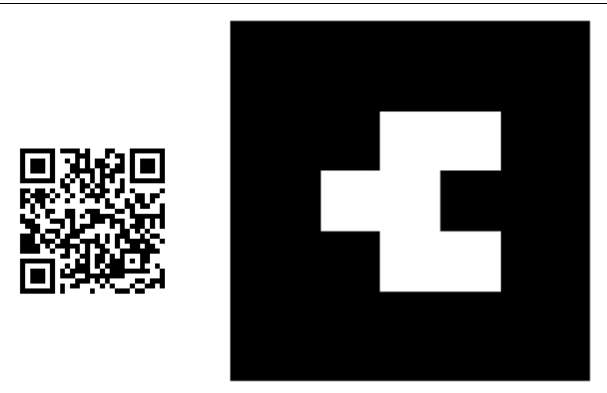
FIGURE 8 | QR code and Augmented Reality (AR) marker showing 3D comparison between the lower teeth morphologies of C. etruscus from Upper Valdarno (blue), Canis from Dmanisi (red), and extant C. lupus (grayish). Instructions: Scan the QR code on the left; open the link, allow the browser to access the camera of your device; point the camera toward the marker (on the right); and wait for the model to load (up to 10 seconds). It is possible to turn the device around the marker (or to move the marker) to see different parts of the model. Best visualization performances can be achieved by printing the markers, rather pointing at them on screens. Refer to Supplementary Material for common issues.